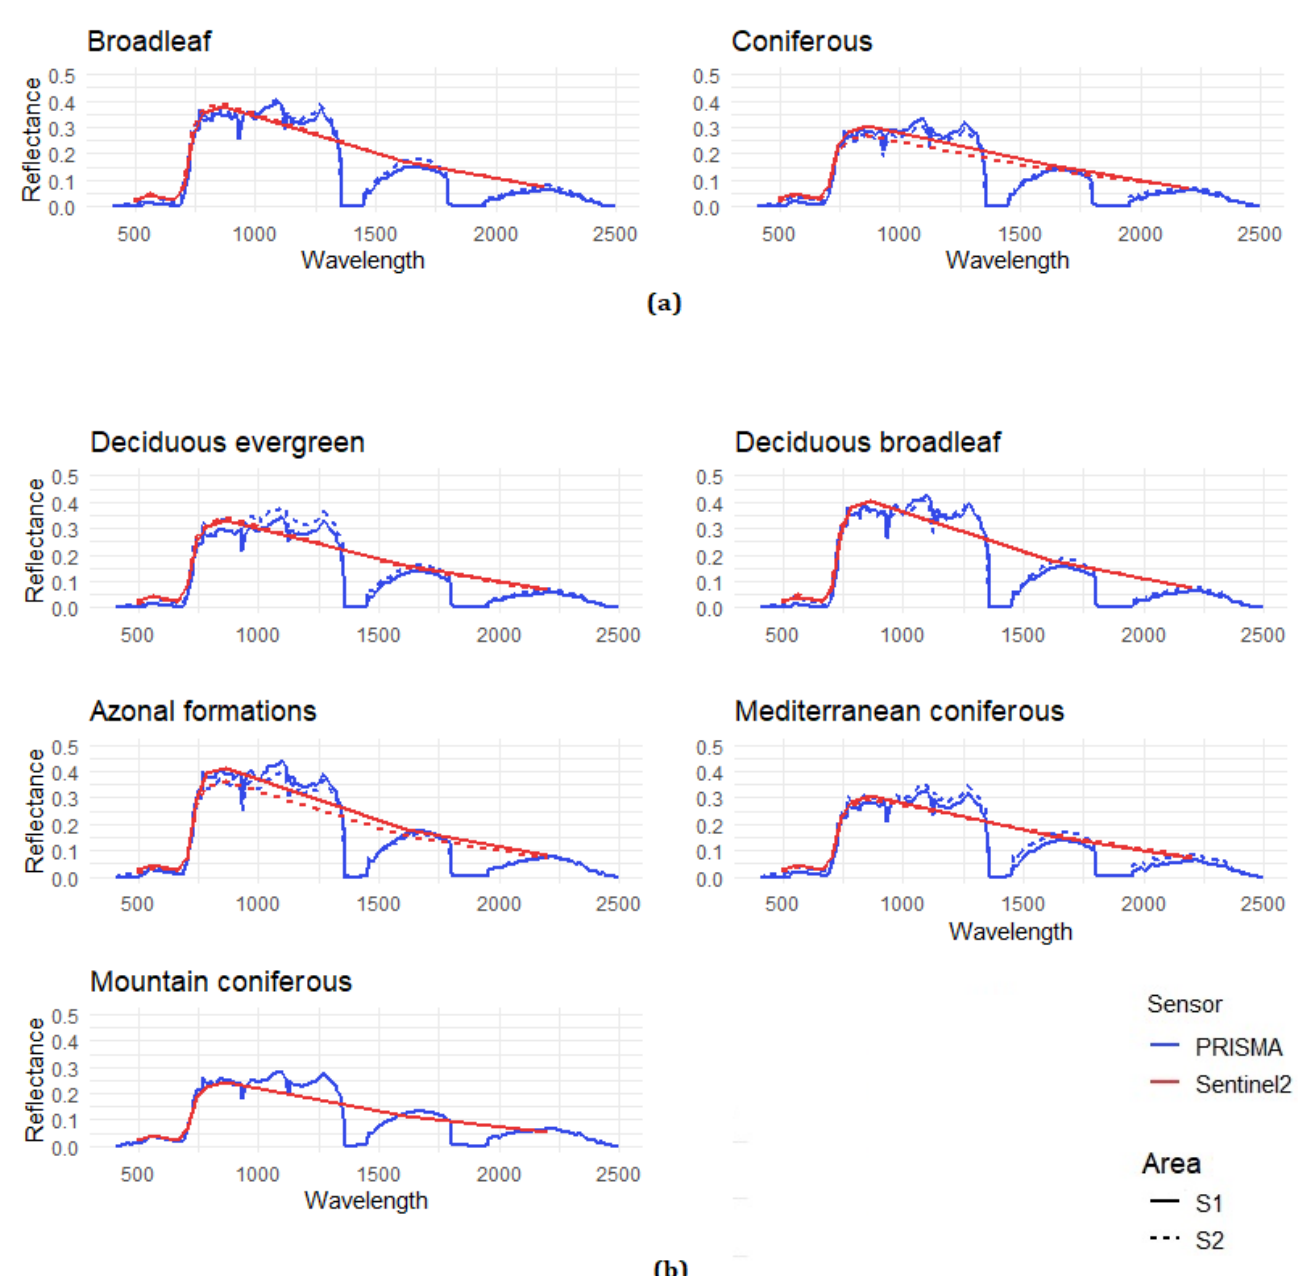
Figure 4. Spectral signatures of the considered forest classes based on PRISMA (blue line) and Sentinel-2 (red line). The solid line for Area 1, the dotted line for Area 2: ( a ) the third level nomenclature system; ( b ) the fourth level.